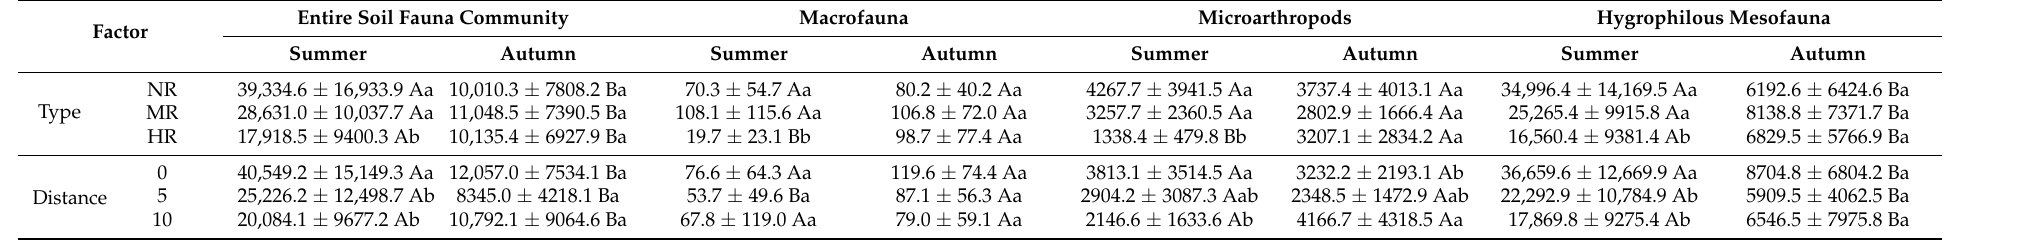
Table A3. Density of the soil fauna (mean ± sd, ind. m − 2 ) of different revetment types and distances in two seasons.